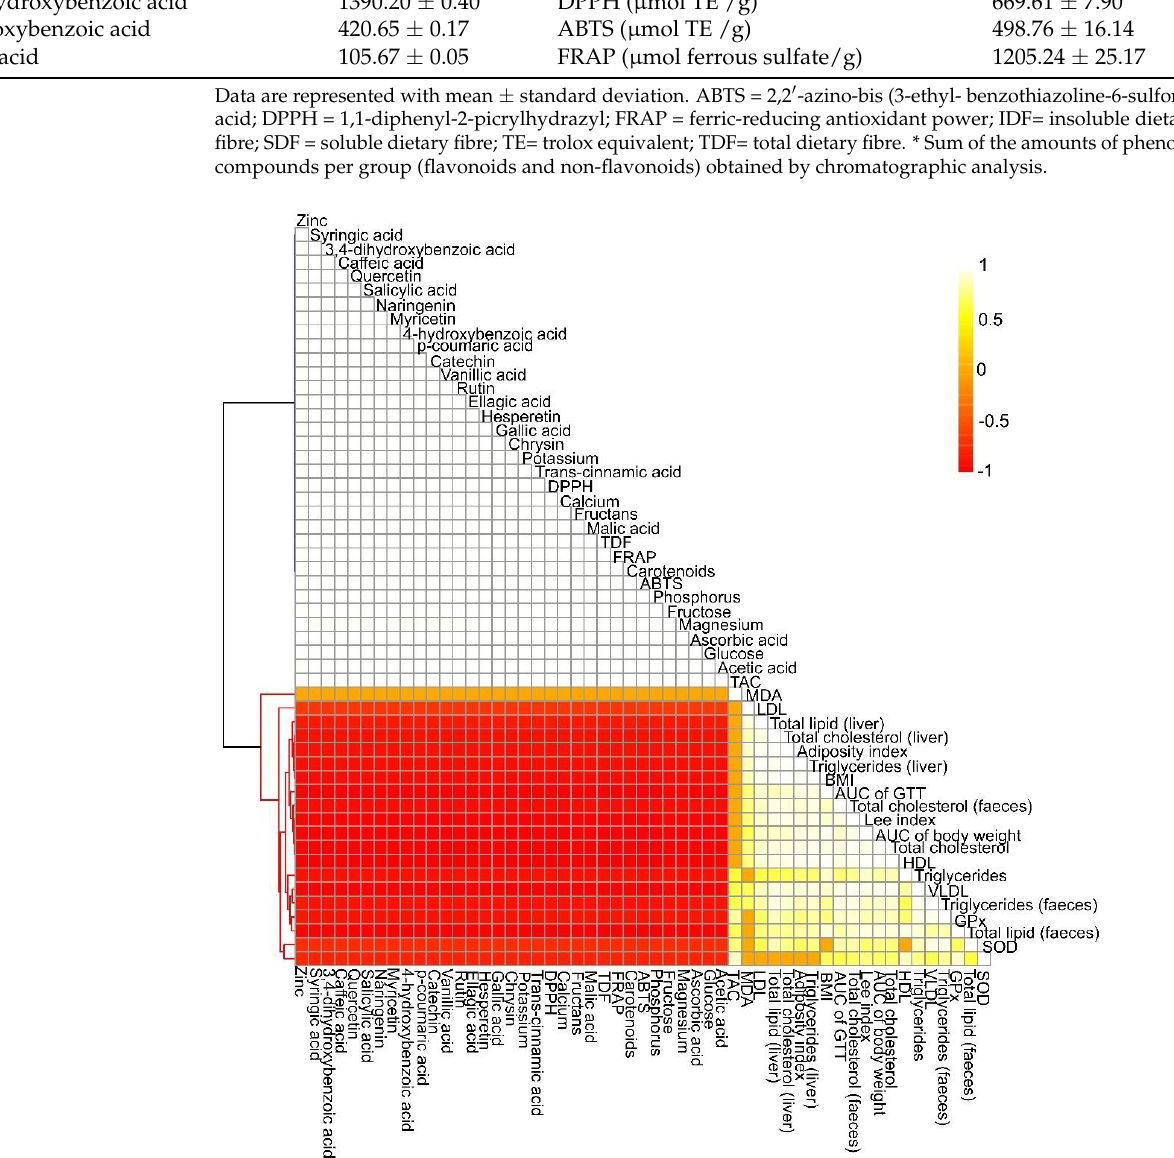
Figure 2. Hierarchical grouping based on Pearson’s correlation matrix between the chemical com- pounds of yellow mombin and the biological parameters of the rats fed a normal or high-fat diet and supplemented or not with yellow mombin. Significant correlations were determined based on r ≥ 0.6 and p ≤ 0.05. Positive and negative correlations are shown as yellow -white and red, respec- tively. Clustering of the correlation matrix reveals two clusters represented by colours: blue (com- pounds of yellow mombin) and red (biological parameters). ABTS = 2,2′ -azino-bis (3-ethyl- benzo- thiazoline-6-sulfonic acid; AUC = area under the curve; BMI = body mass index; DPPH = 1,1-diphe- nyl-2-picrylhydrazyl; FRAP = ferric-reducing antioxidant power; GTT = glucose tolerance test; GPx = glutathione peroxidase; HDL = high-density lipoprotein; LDL = low-density lipoprotein; MDA = malondialdehyde; SOD = superoxide dismutase; TAC = total antioxidant capacity; TDF = total die- tary fiber; VLDL = very low-density lipoprotein.